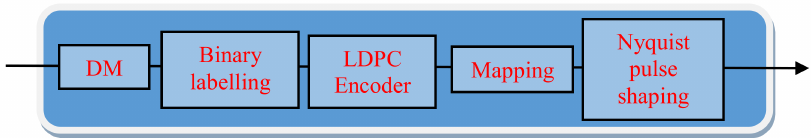
Figure 1. Low-density parity-check (LDPC)-coded, probabilistic shaping, Nyquist pulse shaping, 8-level pulse-amplitude modulation (PS-NPS-8-PAM) signal generator. DM: Distribution